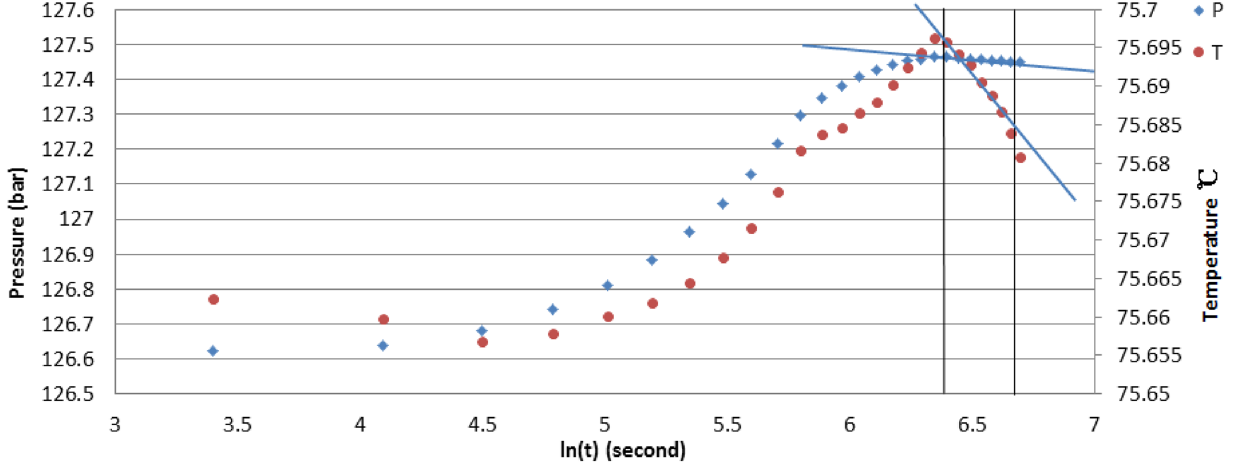
Fig. 17 TTA of transient II: ε ′ = dT / dP = 0.011/0.02 = 0.55 C/bar